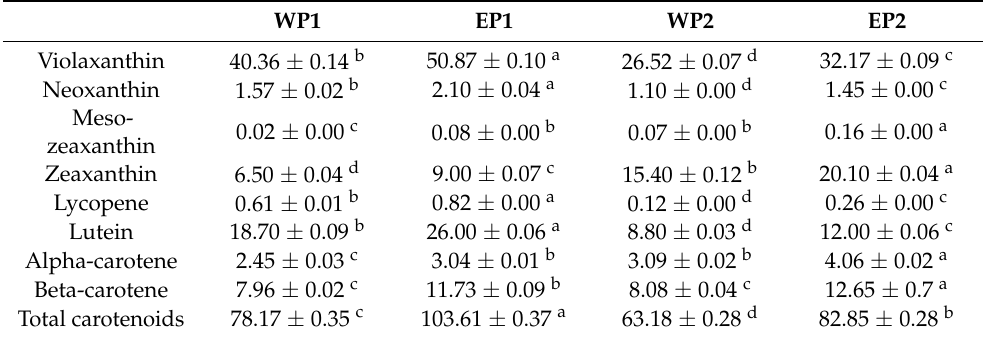
Table 9. Carotenoid content in pepper measured by HPLC-MS/MS (results are expressed as µ g/g d.w.).